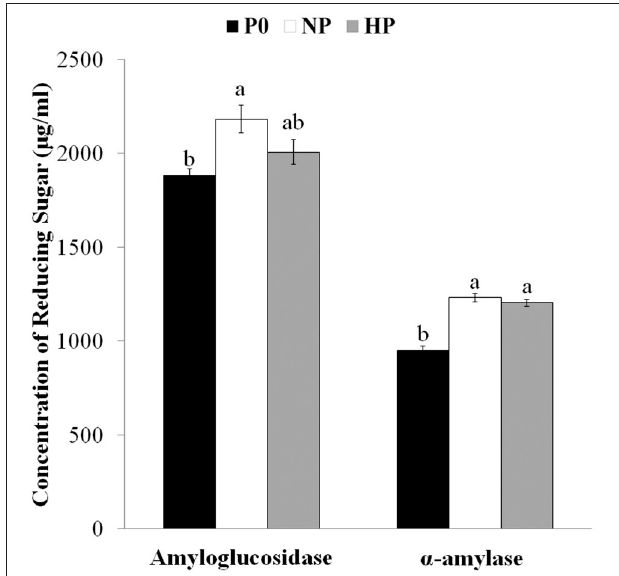
FIGURE 3 | Concentrations of reducing sugars after exogenous enzymatic hydrolysis of starches isolated from mature wheat grain (35 days post anthesis) grown with different P fertilizer amounts. Values are means ± S.E. of three replications. Columns with different letters are significantly different at p < 0.05. P0: 0kg P ha − 1 ; NP: 46kg P ha − 1 ; HP: 92kg P ha − 1